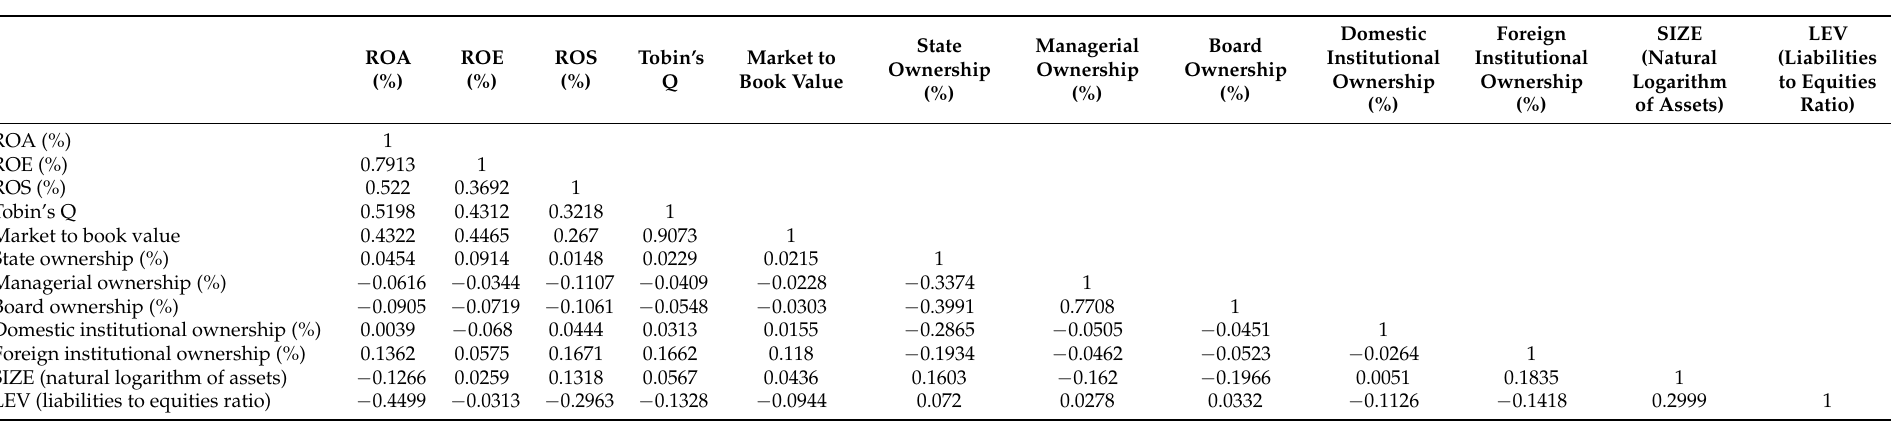
Table A1. Correlation